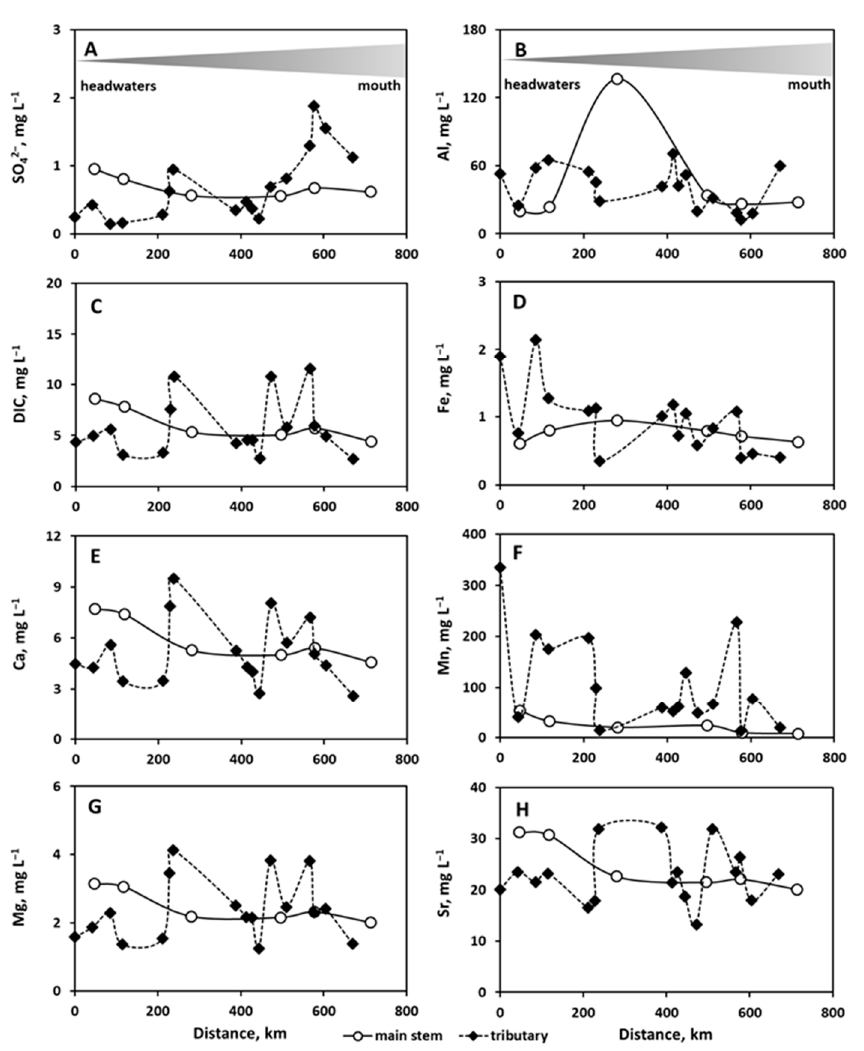
Figure 6. SO 42 − ( A ), Al ( B ), DIC ( C ), Fe ( D ), Ca ( E ) Mn ( F ), Mg ( G ), and Sr ( H ) concentration in the Taz River main stem and tributaries during summer baseflow.